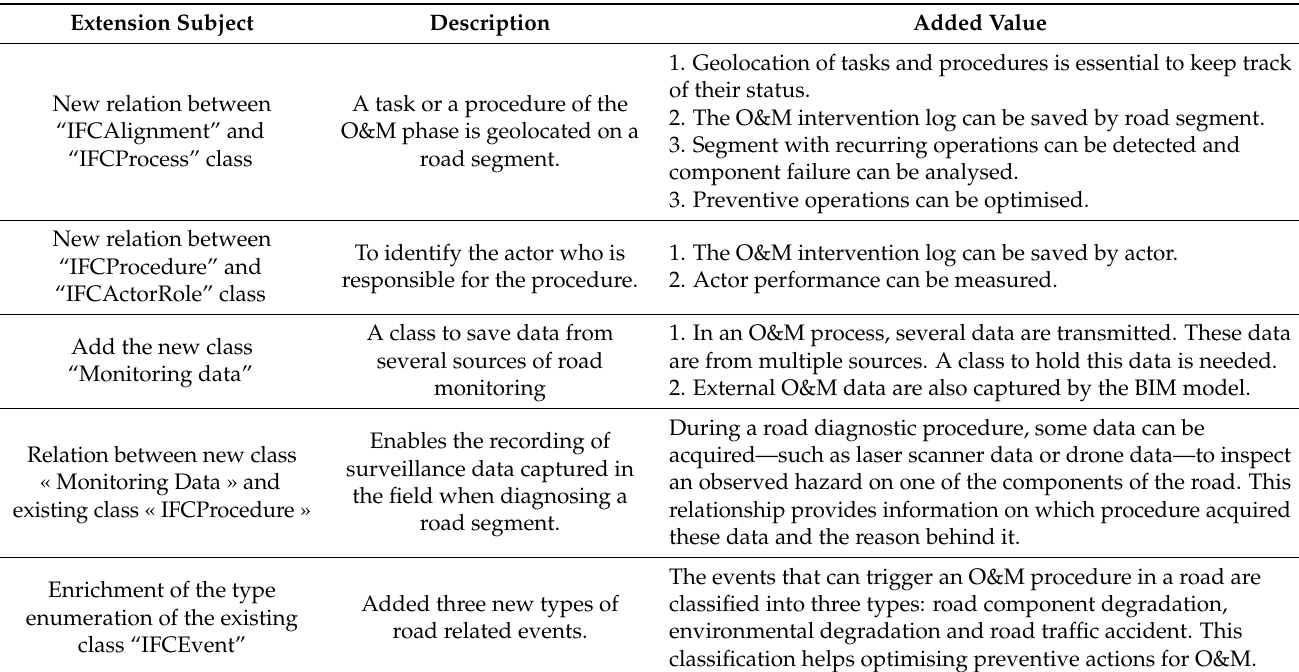
Table 9. Examples of IFC extension by IFCInfra4OM-ontology-added values to enhance IFC capabilities to manage O&M phase for road